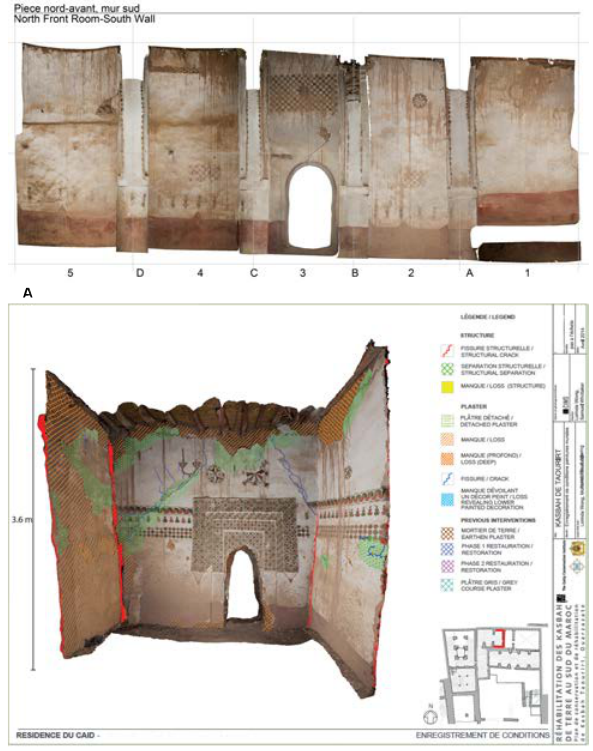
Figure 4: Resulted orthophotograph (A) and 3D condition assessment of ortho photograph (B).